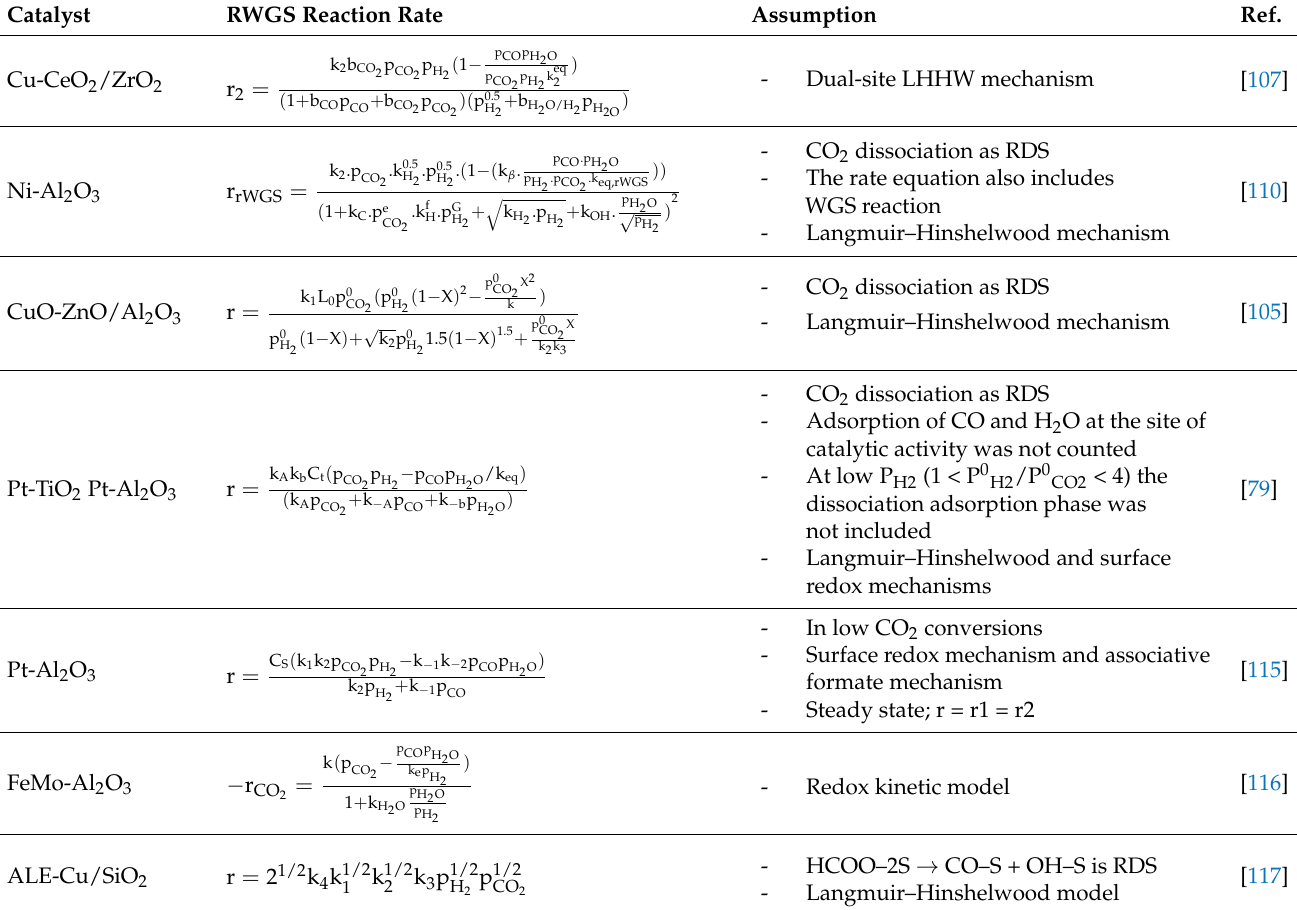
Table 2. Proposed reaction rate for some catalysts in RWGS